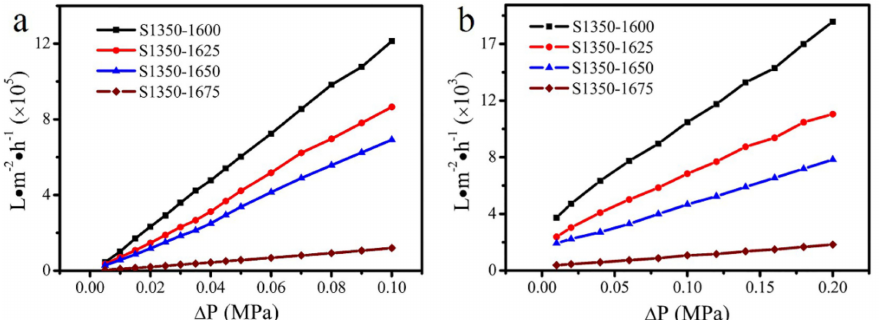
Figure 7. N 2 ( a ) and water ( b ) permeation properties of the membranes sintered at various temperatures. The X -axis is the applied pressure difference between the two sides of a